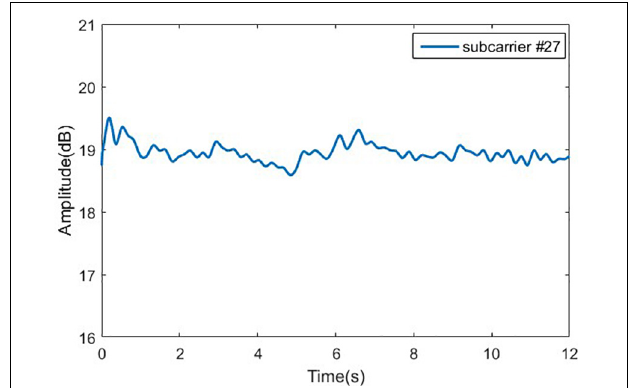
FIGURE 8 | Wavelet transform filtering effect.